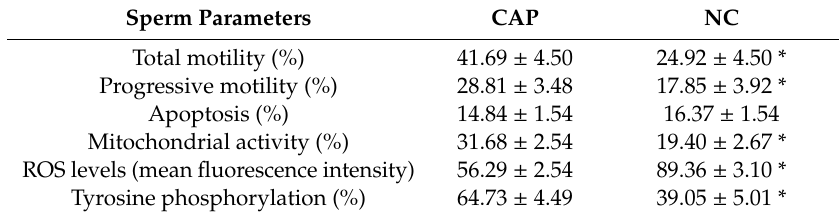
Table 2. Functional parameters of ram sperm during incubation under capacitating (CAP) and non-capacitating conditions (NC). Data represent the average values of fresh and cryopreserved sperm incubated in CAP or NC conditions and are expressed as means ± SEM.